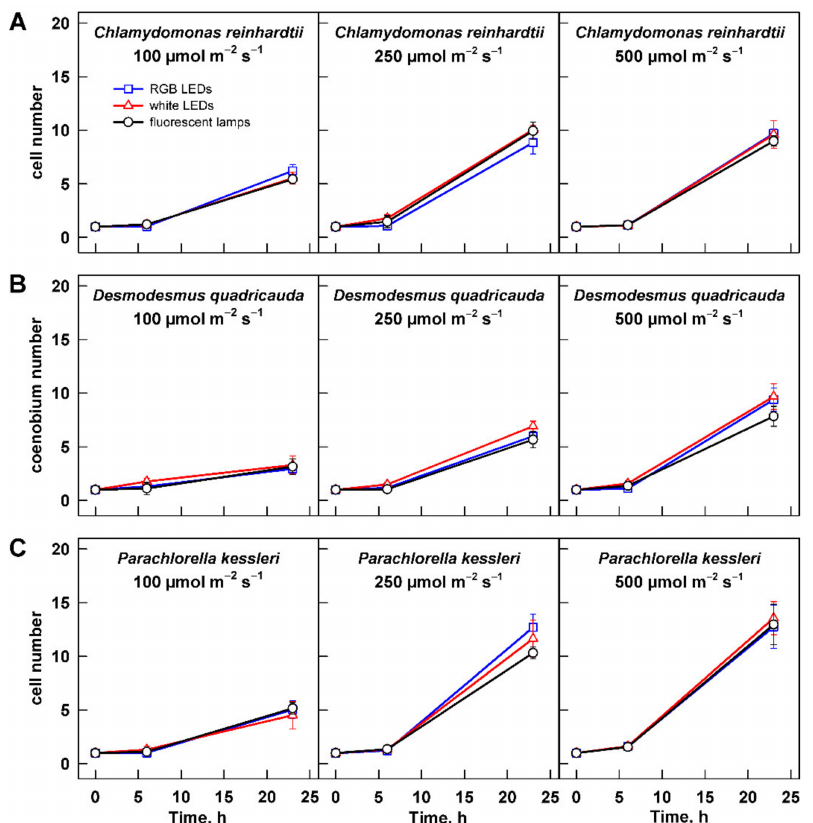
Figure 6. Changes in cell number in the cultures grown at different light intensities. Cultures of ( A ) Chlamydomonas reinhardtii , ( B ) Desmodesmus quadricauda , and ( C ) Parachlorella kessleri were grown at incident light intensity 100, 250, and 500 µ mol m − 2 s − 1 on different light sources: fluorescent lamps (black circles), RGB LEDs (blue squares), and white LEDs (red triangles). Cell numbers were normalized to the initial values to allow direct comparison between treatments and organisms. Data of three biological replicates are presented as means ± SE. Table 3. Cell doubling times (h) of cultures of Chlamydomonas reinhardtii , Desmodesmus quadricauda , and Parachlorella kessleri grown at different incident light intensities. Data were calculated from the interval from 0 to 23 h of cultivation. Light source is stated above the columns. Data of three biological replicates are presented as means ± SE. Values were statistically significantly different between Desmodesmus quadricauda and both Chlamydomonas reinhardtii and Parachlorella kessleri but not between the latter two organisms; they were statistically significantly different for all organisms between 100 and 250 µ mol m − 2 s − 1 as well as 100 and 500 µ mol m − 2 s − 1 but not between 250